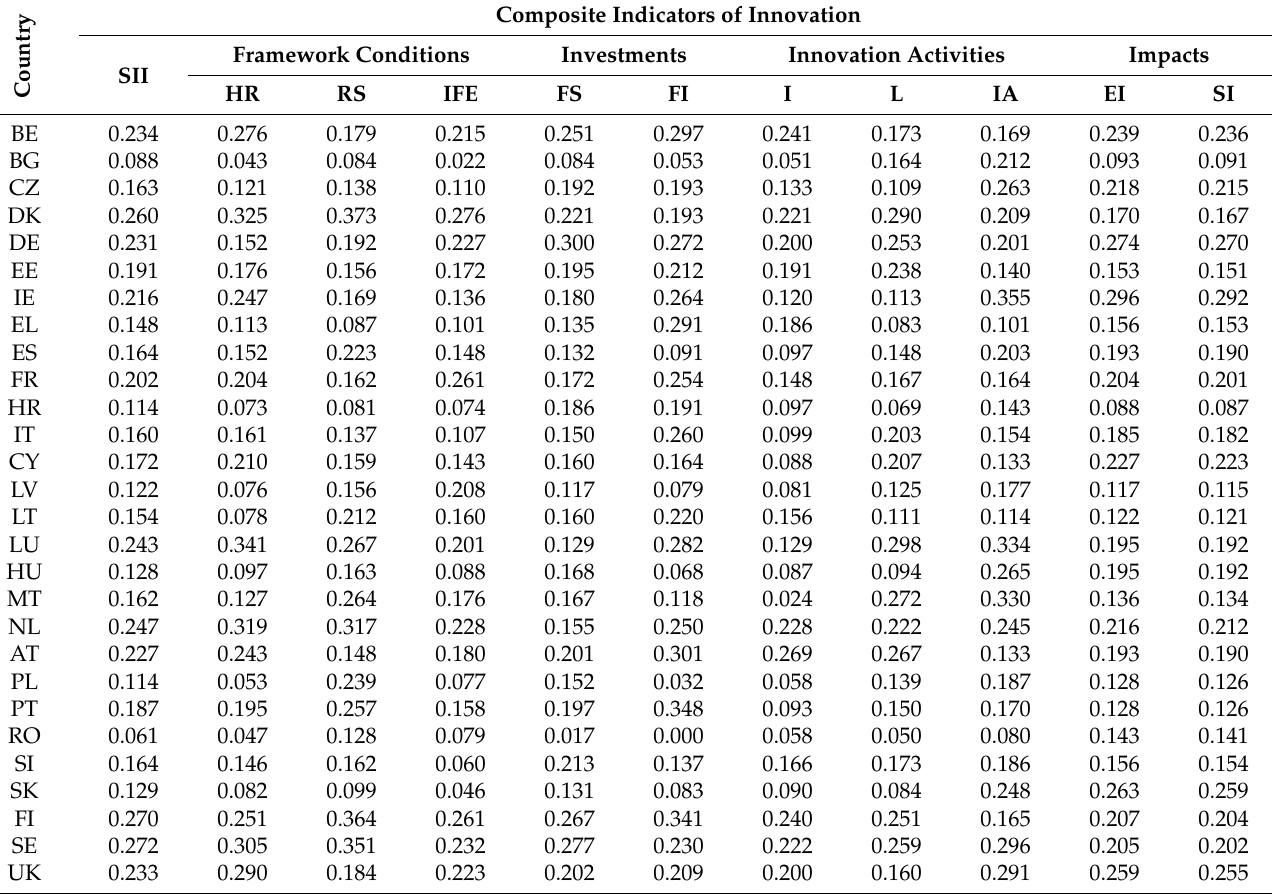
Table 8. Key innovation indicators 2019—EU countries—normalization